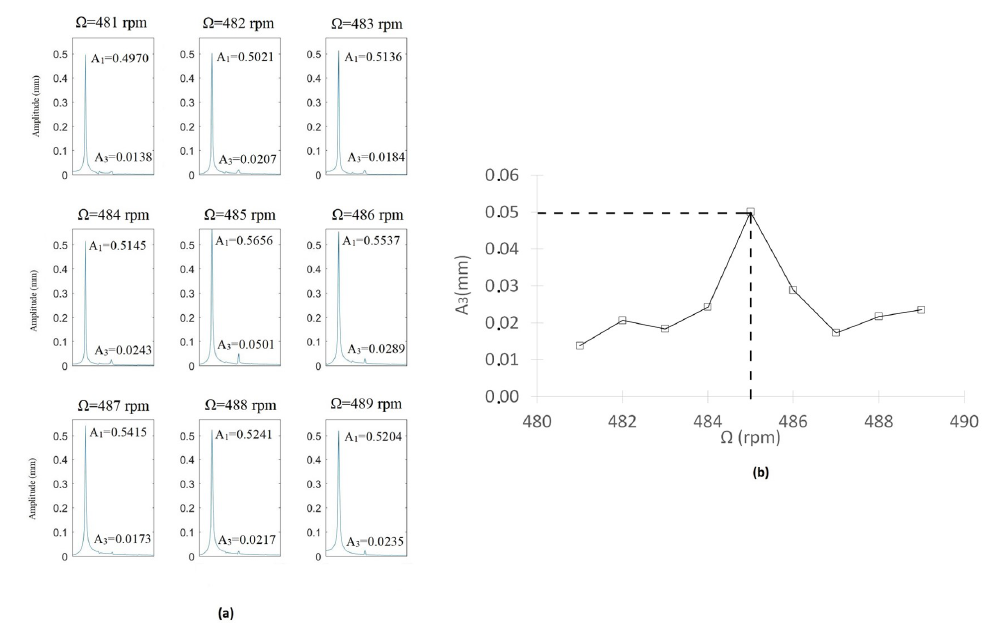
Figure 19. FFT of the displacements of the intactshaft around 3 X . ( a ) FFT for different speeds of rotation. ( b ) Maximum values of the amplitude of A 3 in each